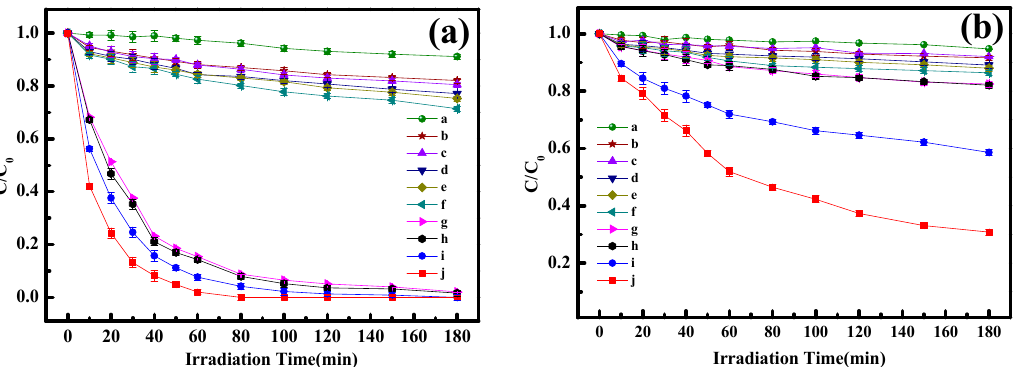
Figure 7. ( a ) Degradation of bisphenol A (BPA) under di ff erent conditions. ( b ) Mineralization of BPA under di ff erent conditions. (a) Vis; (b) H 2 O 2 ; (c) H 2 O 2 / ZnAl–LDH; (d) H 2 O 2 / FePcS–LDH; (e)